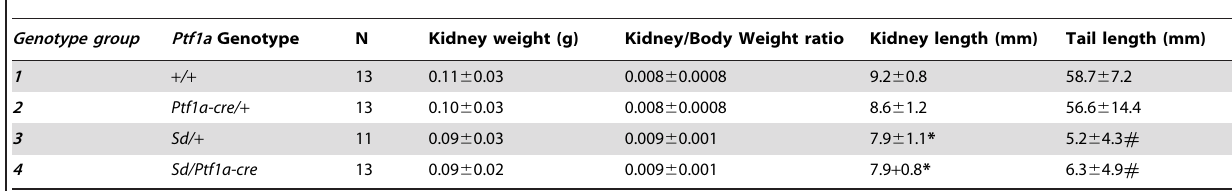
Table 1. Phenotypes of ( Sd/ + X Ptf1a-cre/ + ) F1 mice.